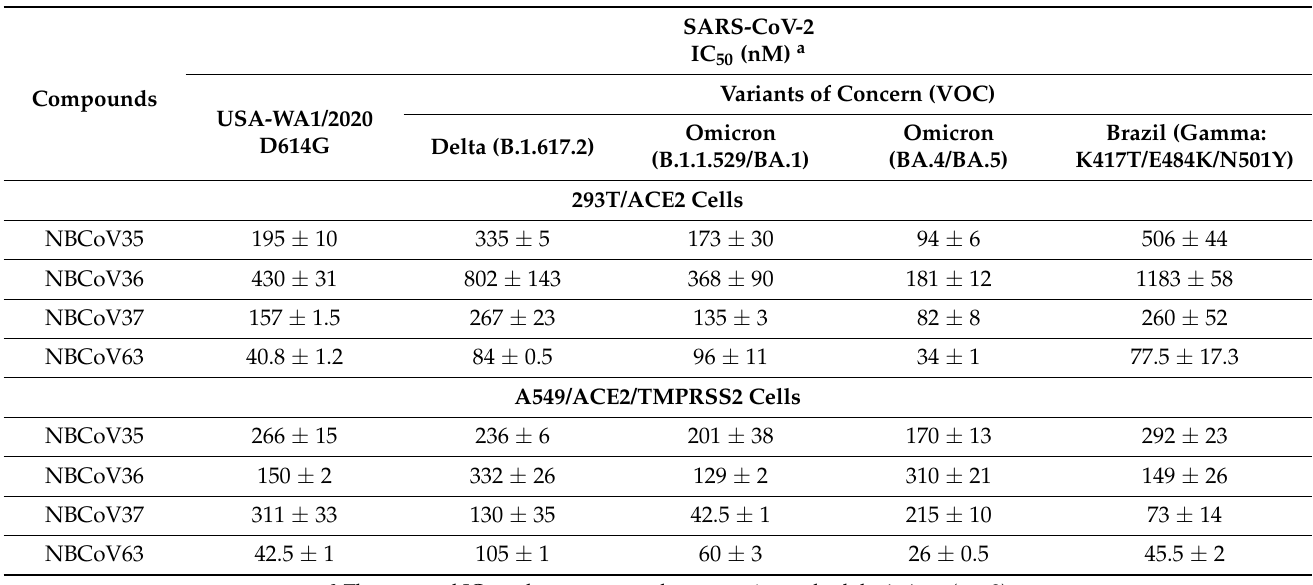
Table 2. Antiviral activity of the NBCoV small molecules in the single-cycle assay in two cell lines against pseudovirus NL4-3 ∆ Env -NanoLuc/SARS-CoV-2 mutant (D614G) and its variants of concern (VOC) (IC 50 ).